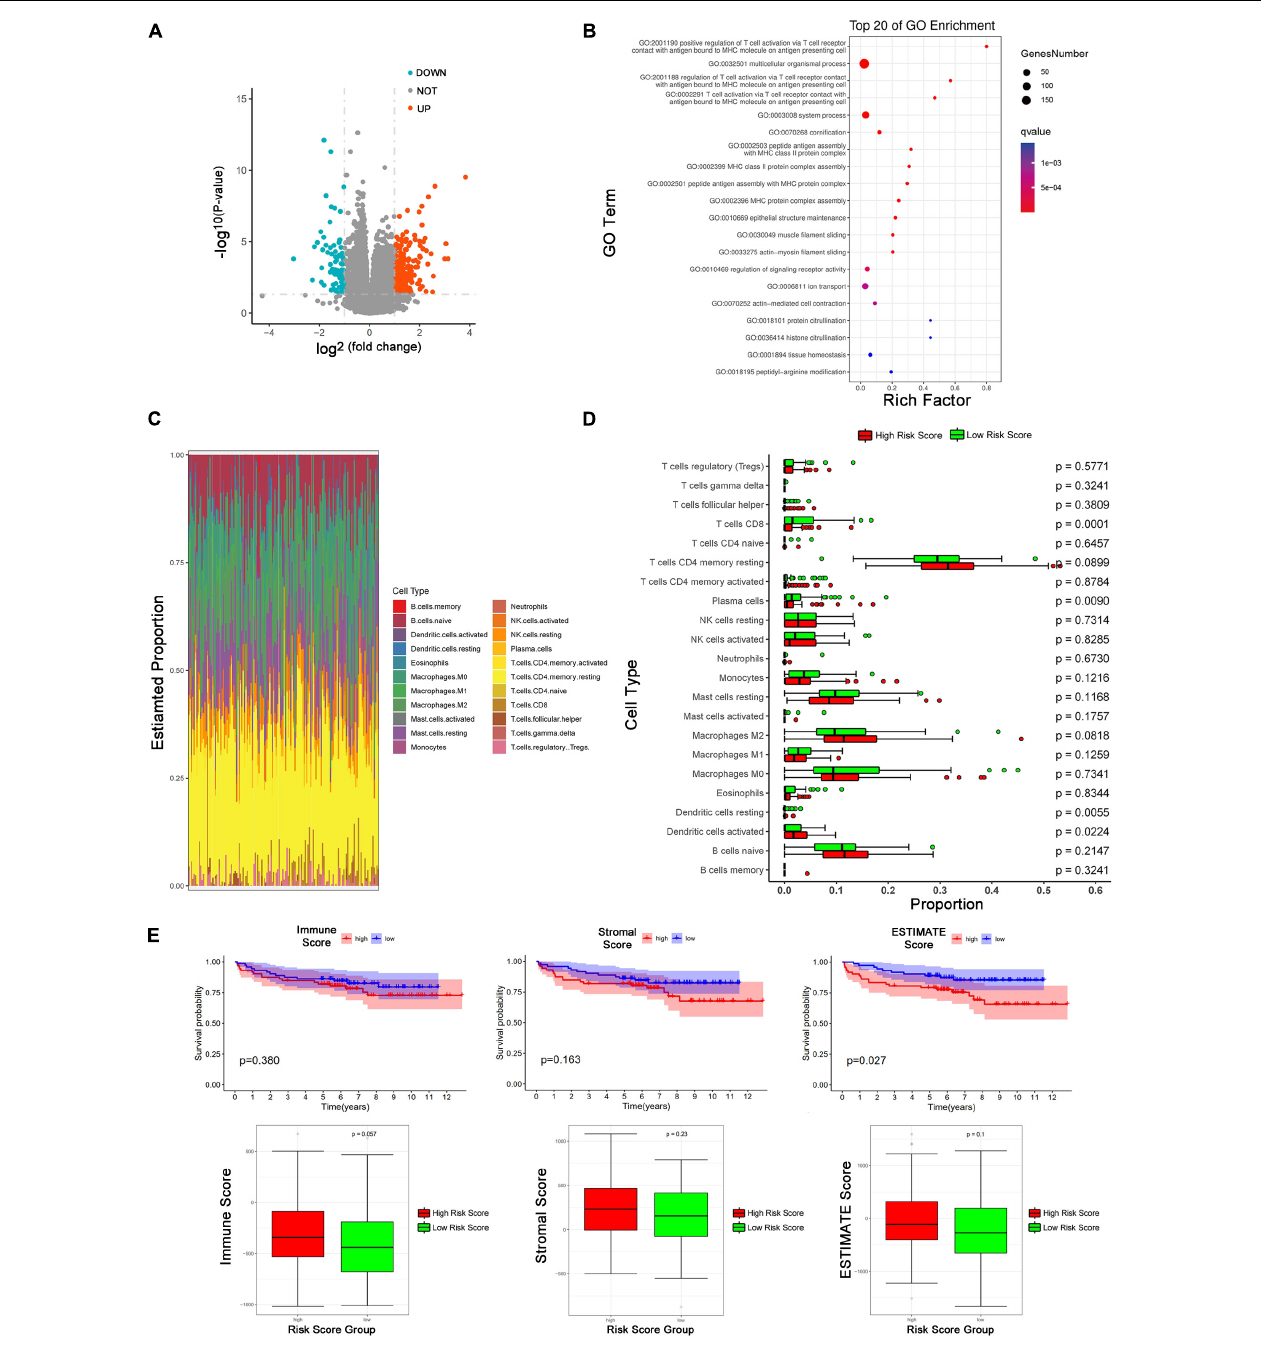
FIGURE 5 | Tumor immune microenvironment between low-risk and high-risk score group. (A) Volcano Plot shows the differentially expressed mRNAs between high and low risk score groups (The cutoff value is |logFC| > 1 and p < 0.05). (B) GO pathways analysis of differentially expressed mRNAs. (C) The proportion of 22 kinds of immune cells in individual. (D) The proportion of 22 immune cells between high and low risk score groups. The red means high risk score and the green represents low risk score. The parameter p -value was obtained by Wilcoxon test. (E) Kaplan-Meier analysis of BCR and the comparison of different risk-score group based on immune score, stromal score, and estimate score from ESTIMATE